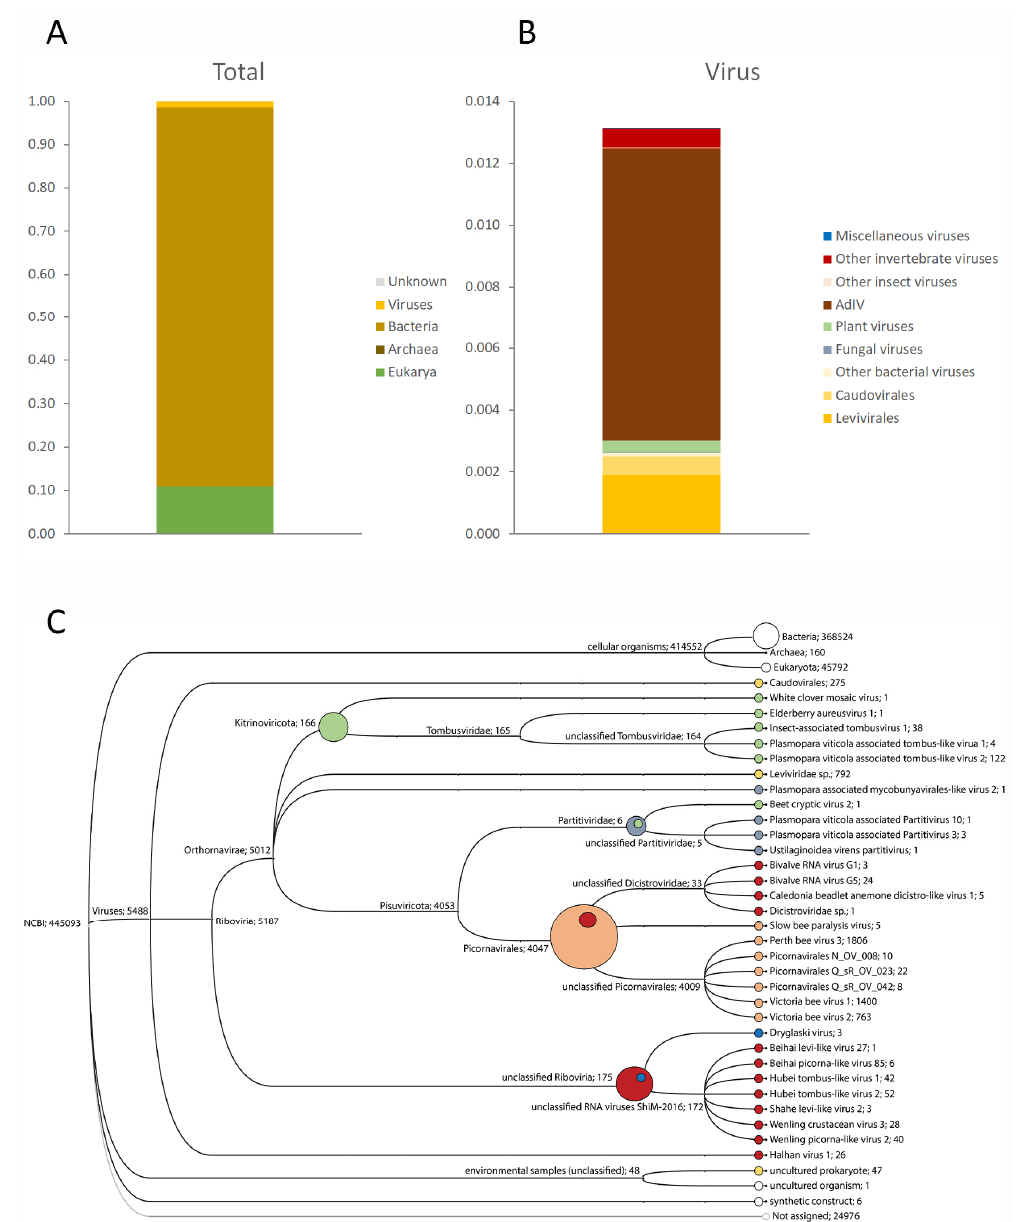
Figure 1. Taxonomic composition of Acheta domesticus frass. ( A ) Full composition of the wild Acheta domesticus frass sample at the level of Domain (Archaea, Bacteria, Eukarya, and Viruses) as determined by RNA sequencing. ( B ) Composition of the 1% virus subfraction, separated by primary host: bacteria (yellow), fungi (grey), plants (green), insects (orange), invertebrates (red), and miscellaneous viruses (blue) whose host status is unclear. ( C ) Cladogram of the viral reads obtained through RNA sequencing, with the primary hosts of the virus identified by coloured dots, as for Figure 1B. The composite circles represent the host distribution at higher virus taxonomic categories. The numbers indicate the number of unique reads assigned to the corresponding taxon.